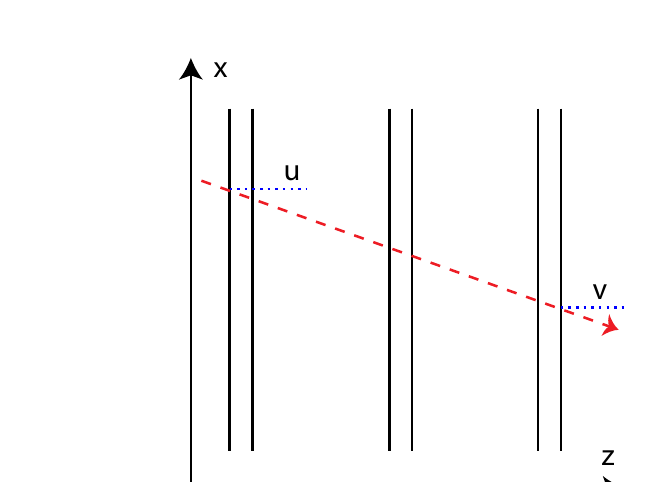
Figure 4: Sketch of the 6-layer telescope used for the prototype, showing also the two parameters u and v used to represent a